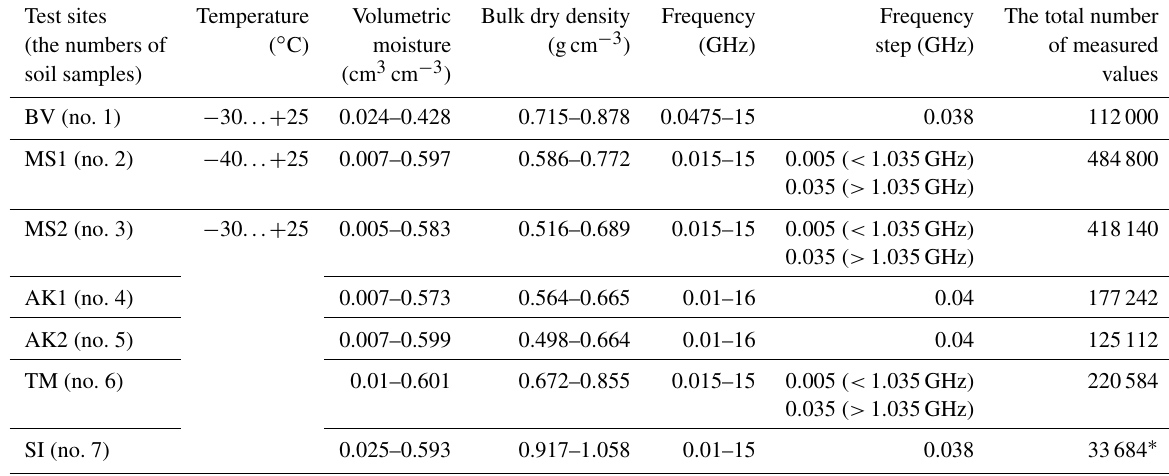
Table 2. Range of variations in temperature, moisture, the density of soil samples and wave frequency when measuring RI and NAC of soil samples.